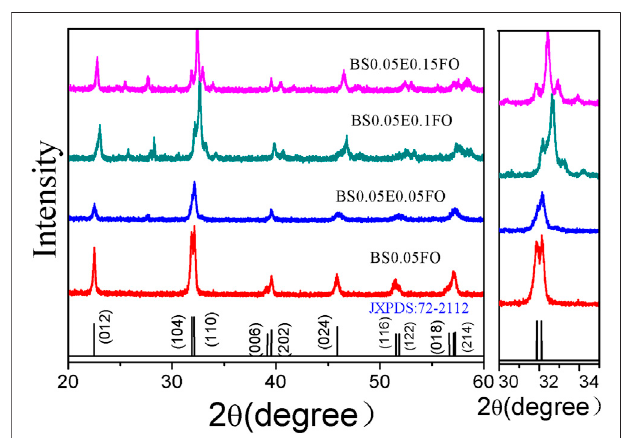
FIGURE 1 | XRD patterns of the Bi 0.95 Sm 0.05 Fe 1 − x Eu x O 3 ( x = 0.0, 0.05, 0.10, 0.15) ceramic samples, with enlarged views of the (104) and (110) diffraction peaks near the diffraction angle 2 θ = 32 °